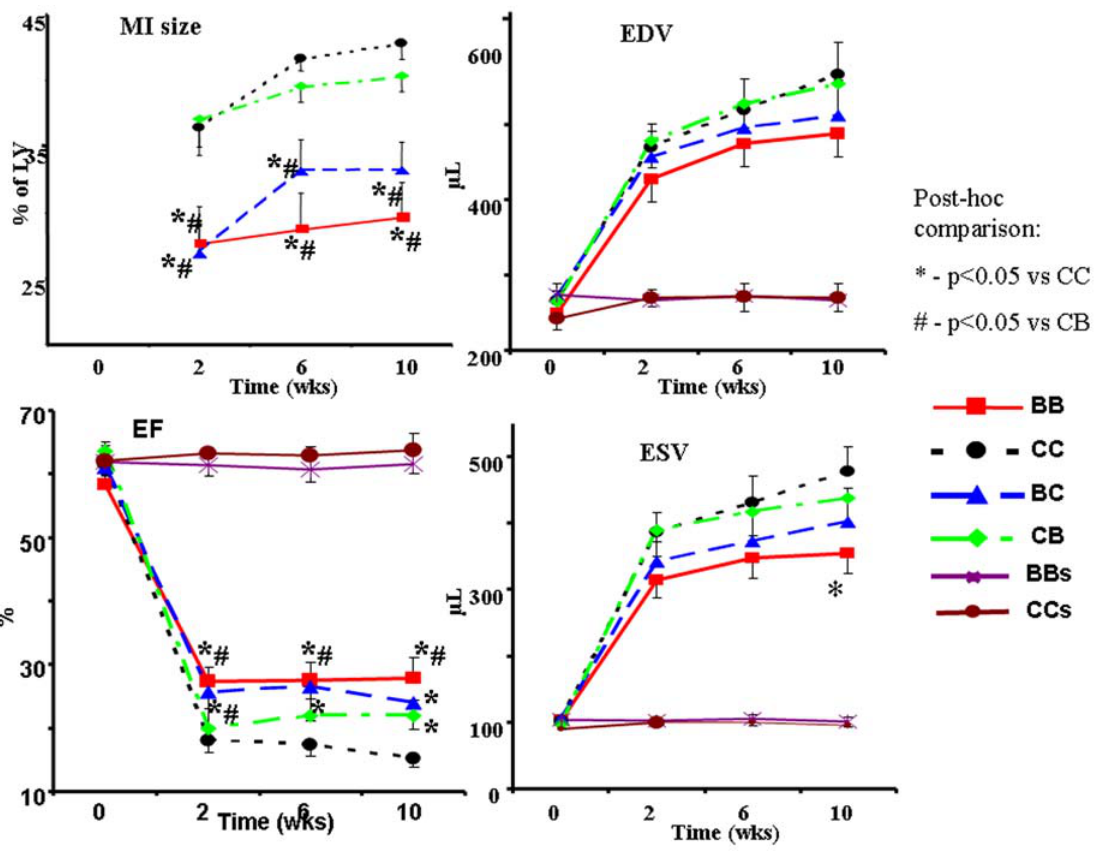
Figure 5. LV remodeling and MI expansion. Echo derived EDV, ESV, EF, and MI size during 10 weeks of post MI observation. Data on sham operated groups (BBs and CCs) is shown for refernce and is not included in statistical comparison. *- p , 0.05 vs. CC; # - p , 0.05 vs